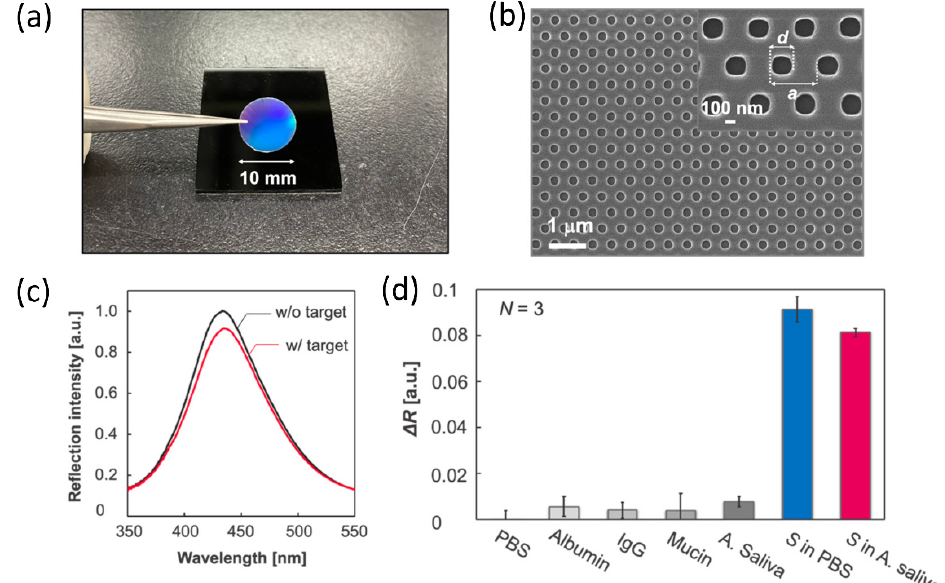
Figure 8. Responsive photonic crystals for label-free specific detection of SARS-CoV-2 spike proteins. ( a ) Image of the photonic crystal chip. The diameter of the chip used for the sensor was 10 mm. ( b ) SEM image of the photonic crystal surface. ( c ) Reflection spectrum of the photonic crystal before and after incubation in a sample solution containing spike proteins. ( d ) Detection selectivity for the spike proteins. Reprinted from [169], with permission from MDPI.